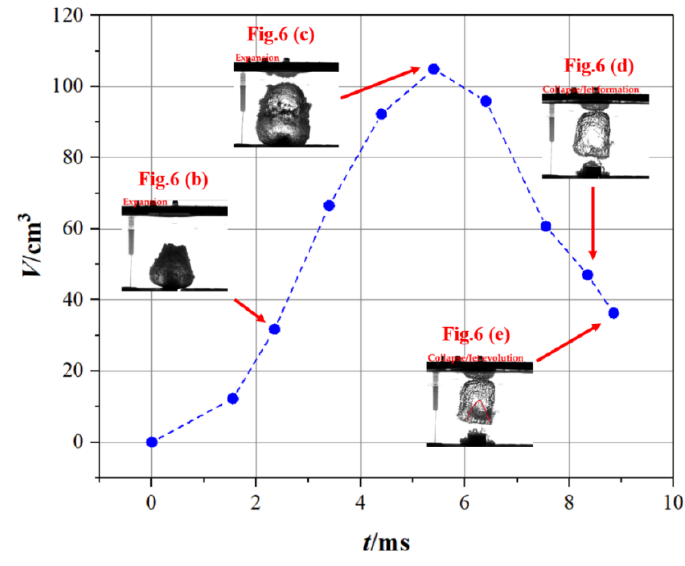
Figure A2. Volume variation of the bubble in Figure 6.